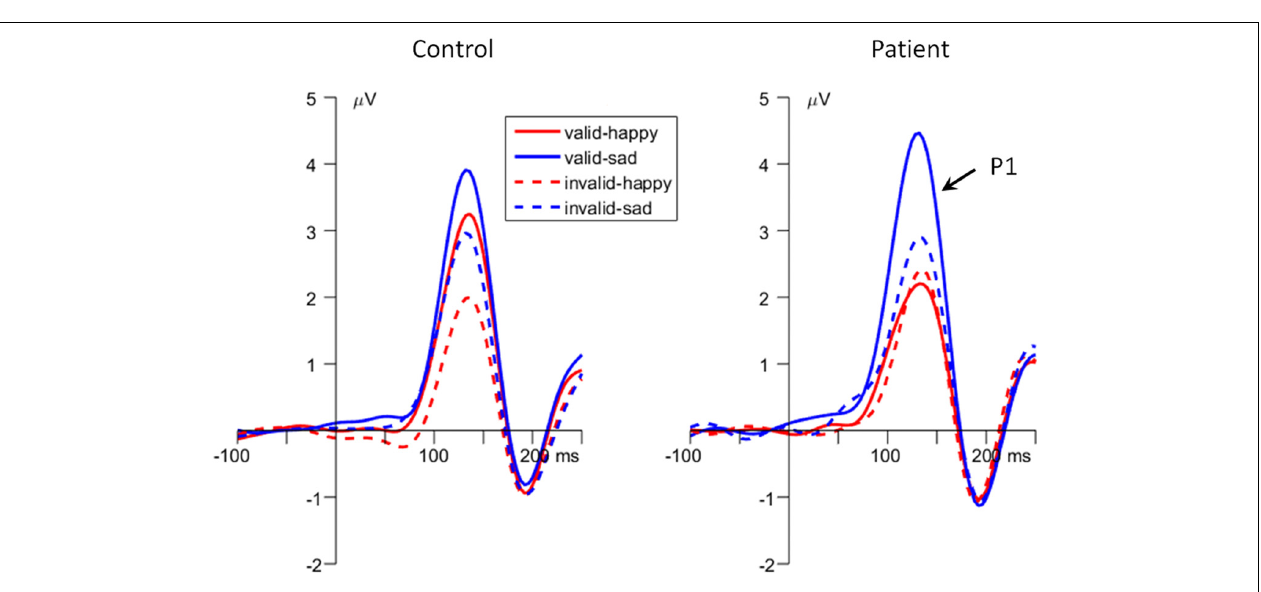
FIGURE 3 | The grand-mean event-related potential (ERP) waveforms of P1 component in the two groups (data averaged at the occipital electrode site of O1 and